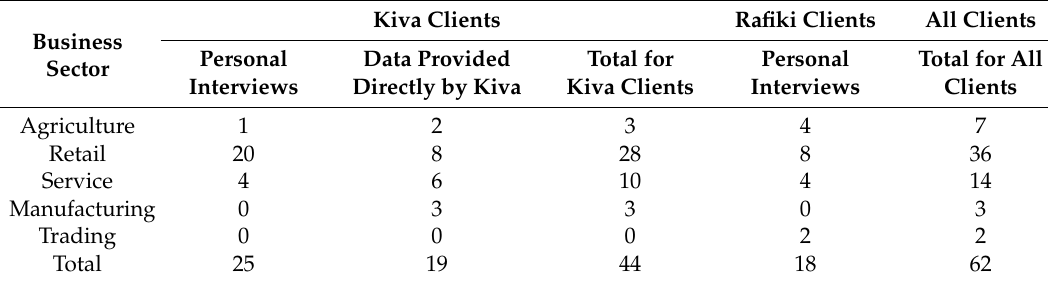
Table 6. Number of loans by business